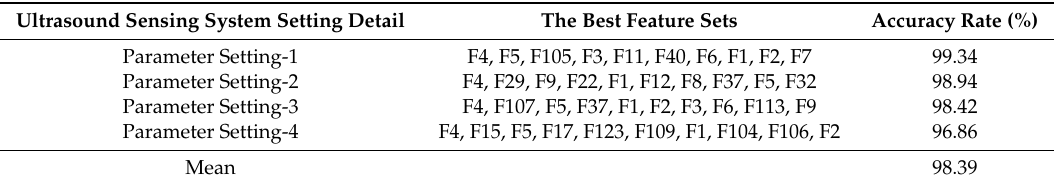
Table 16. Classification results of the SVM-enabled intelligent genetic algorithmic model when it chooses 10 features in each parameter setting.